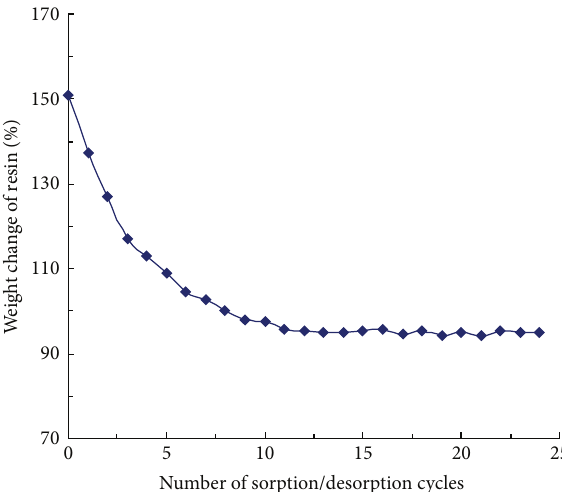
Figure 2: Effect of CAB/resin ratio (g CAB/g dry resin) on the EIR preparation at the conditions in which portions of 1g of the dry polymer beads of Amberlite XAD-2010 were subjected to the impregnation process in 200 mL methanol.